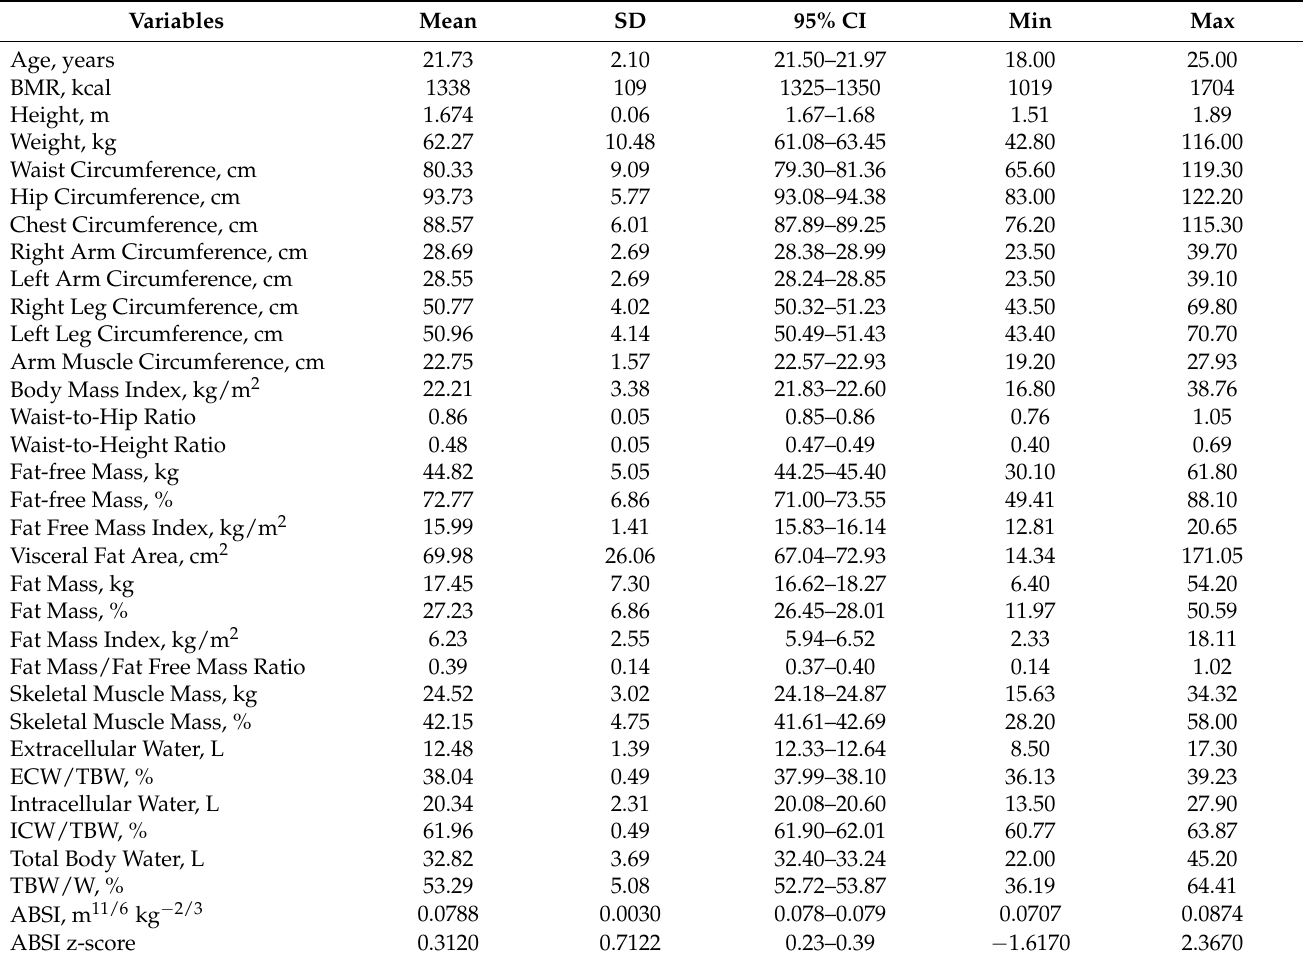
Table 1. Characteristics of the participants ( n =